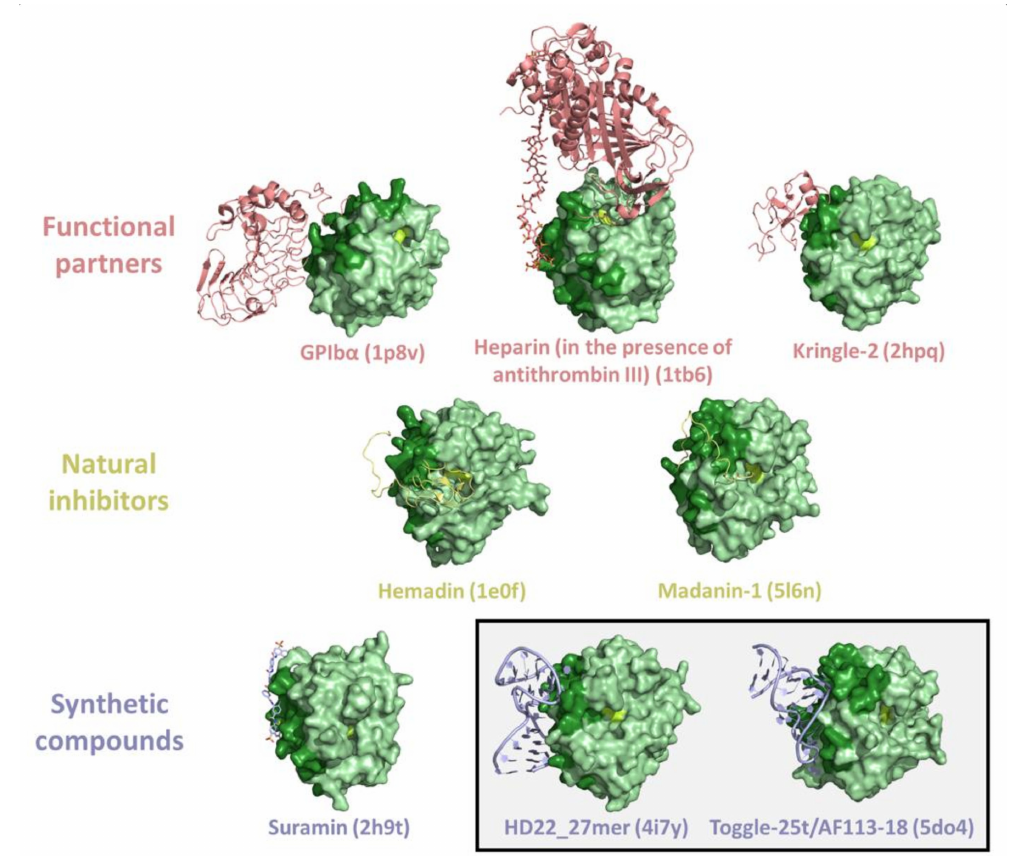
Figure 6. Representative examples of crystallographic structures of thrombin complexes with exosite II interactors (PDB entries are within brackets). The exosite II and the active triad of thrombin are in dark green and lemon, respectively. A box identifies the thrombin-aptamer